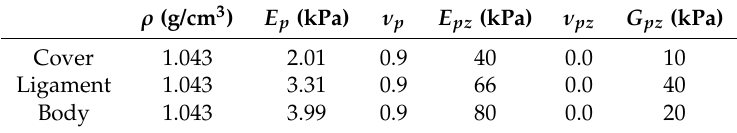
Table 3. Material properties of each layer of the vocal fold.